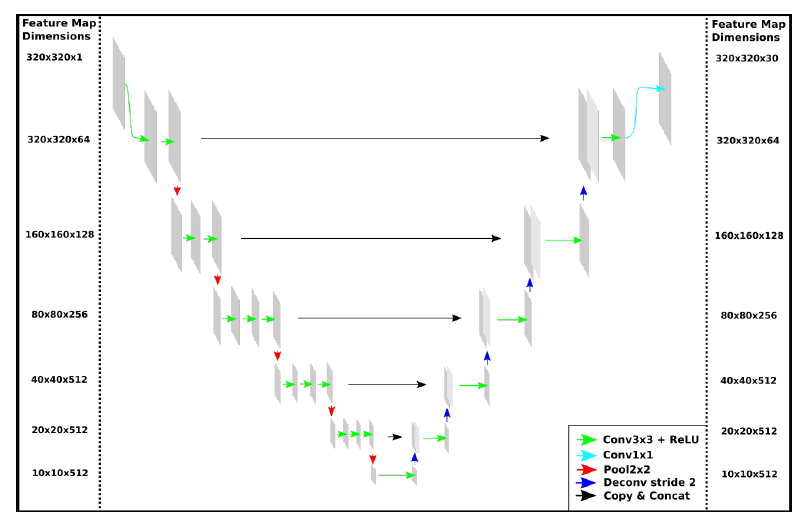
Figure 2. The proposed adapted Unet architecture.